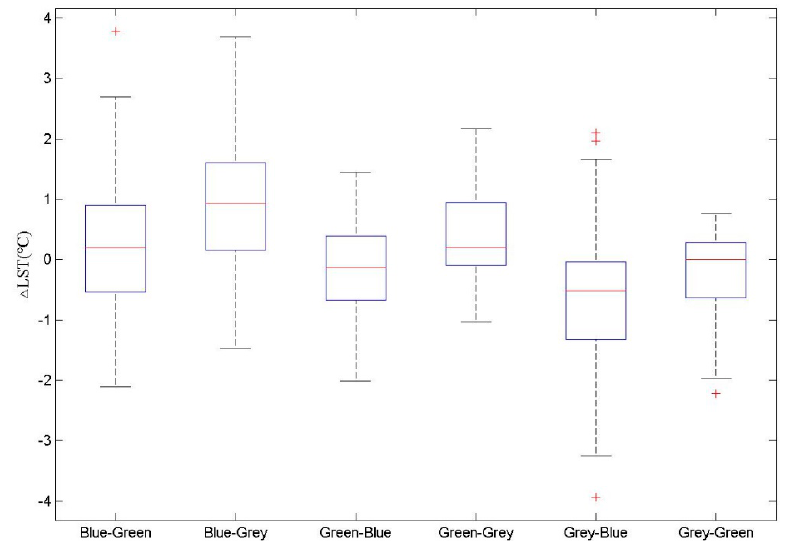
Figure 8. Mean changes of land surface temperature resulting from six types of landscape transformation. (“Blue-Green” means a transformation from Blue landscape to Green landscape, with the others for similar meaning.)